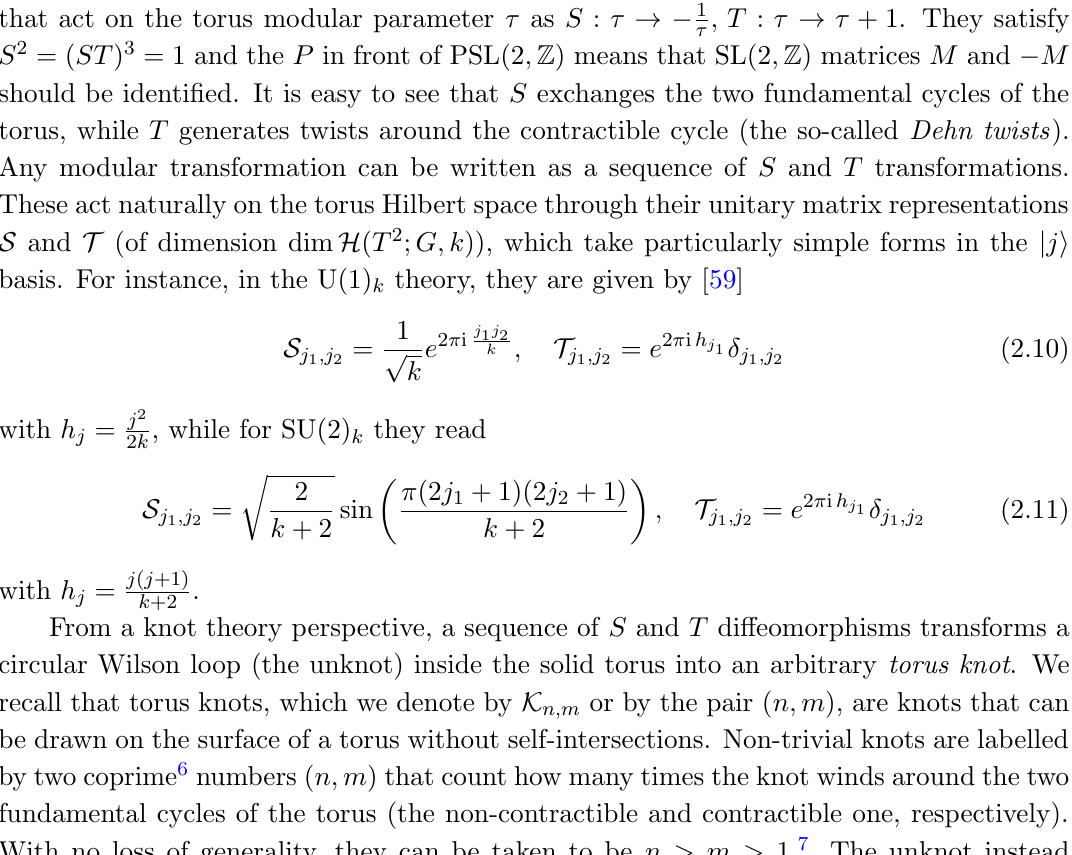
Figure 3. The (cid:12)rst few non-trivial torus knots as told by their crossing number, namely K 3 ; 2 (the trefoil ), K 5 ; 2 , K 7 ; 2 , K 4 ; 3 , K 9 ; 2 , K 5 ; 3 , K 11 ; 2 , and K 13 ; 2 ((cid:12)gure taken from [60]). We recall that the crossing number of a ( n; m ) torus knot is cr( K n;m ) = min